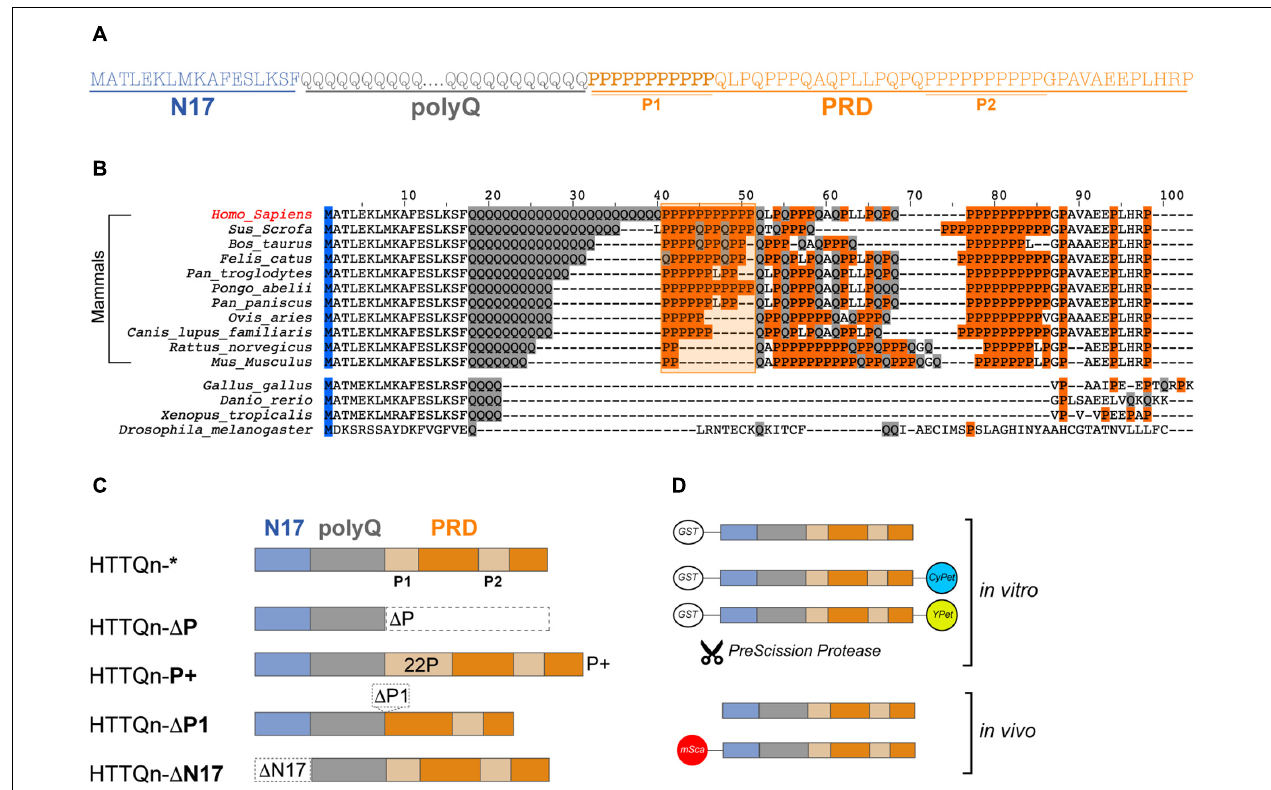
FIGURE 1 | Huntingtin exon 1: Sequence, evolution, key domains and their variations. (A) Amino acid sequence of human HTTEx1 and its domains: the first 17 amino acids (N17 – light blue), the variable polyglutamine region (polyQ – gray) and the proline rich domain (PRD – orange), which includes two stretches of pure polyproline (P1 and P2). (B) Alignment of human huntingtin HTTEx1 and of selected species. Amino acids relevant for this study are highlighted: glutamines (Q) in gray, prolines (P) and the P1 region, shaded and contoured, in orange. (C) Schematics of the HTTEx1 mutants generated for this study: HTTQn* is the non-variated HTTEx1, in HTTQn- (cid:49) P the proline rich domain (PRD) was deleted; in HTTQn- P+ the first proline stretch (P1) of the PRD was expanded from 11 to 22 prolines; in HTTQn- (cid:49) P1 the whole first proline stretch (P1) has been deleted; and in HTTQn- (cid:49) N17 the first 17 amino acids have been deleted. Domains are color coded throughout the study: N17 in light blue, polyQ in gray and PRD in orange. Regarding the polyQ, all mutants contain either a non-expanded and physiological Q23 or pathogenic Q48 stretch. (D) Graphical representation of the fusion constructs used in this work: for the in vitro investigations, HTT constructs are tagged N-terminally to a removable GST-tag, and C-terminally to either CyPet or YPet fluorophore, or nothing. For the in vivo analysis, HTTEx1 is either fully untagged, or fused N-terminally with a nematode adapted mScarlet